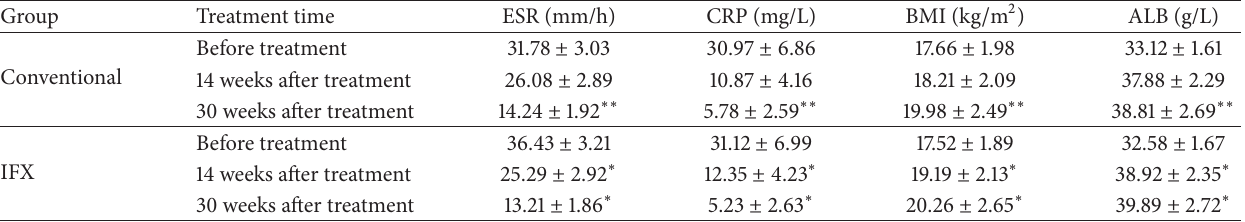
Table 2: Comparison of laboratory indexes and BMI before and after treatment in 42